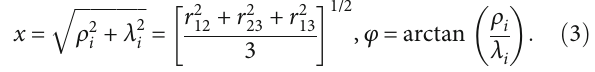
3 for three particles in six dimensions p 2 i =1 i